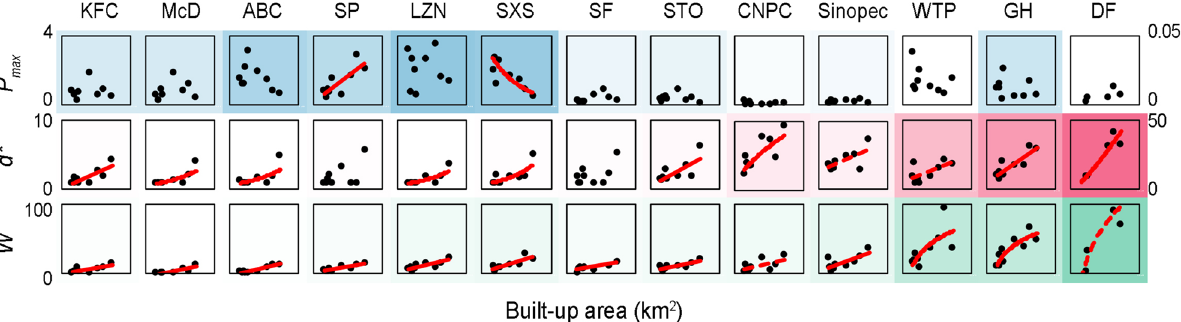
Figure 3. Relationship between the characteristic values ( P max , d * , W ) of the density distribution curves of the city functional components and the city size (built-up area). The WTP and DF components use secondary coordinates. The red line indicates the results of correlation analysis of the scatter points in the figure, all p values < 0.05. The depth of the background colour indicates the mean value of the ordinate of the scatter points in each small figure. The abbreviations of the component names are the same as those in Fig. 1.